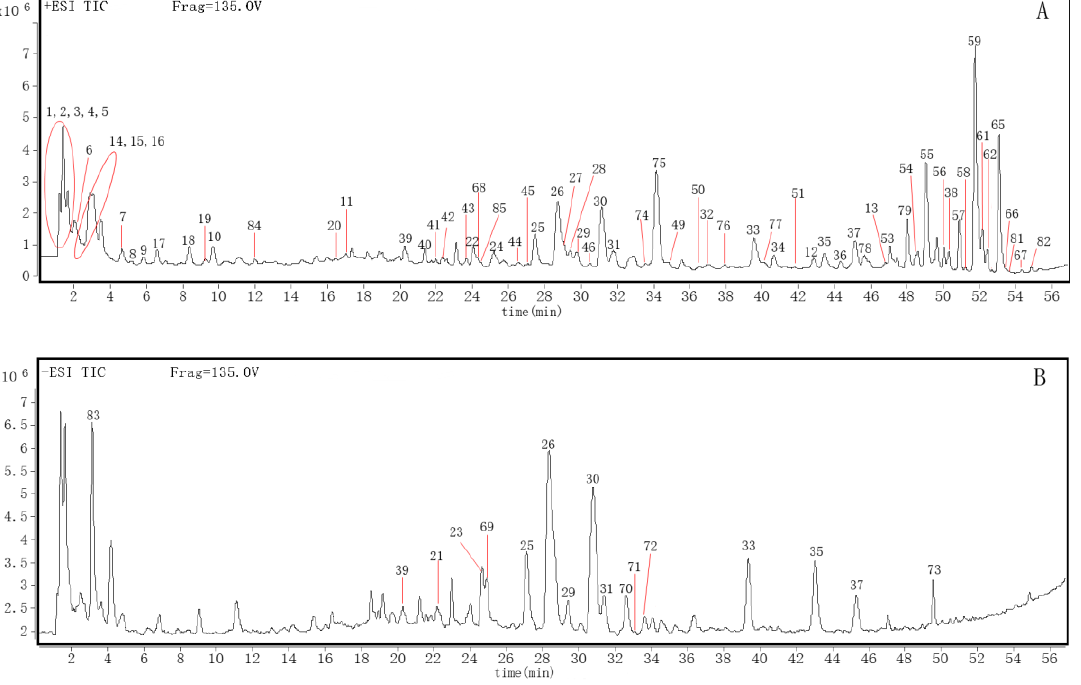
Figure 1. Total ion chromatography of ethanol extract from Aurantii fructus in positive ( A ) and negative ( B ) ion modes.